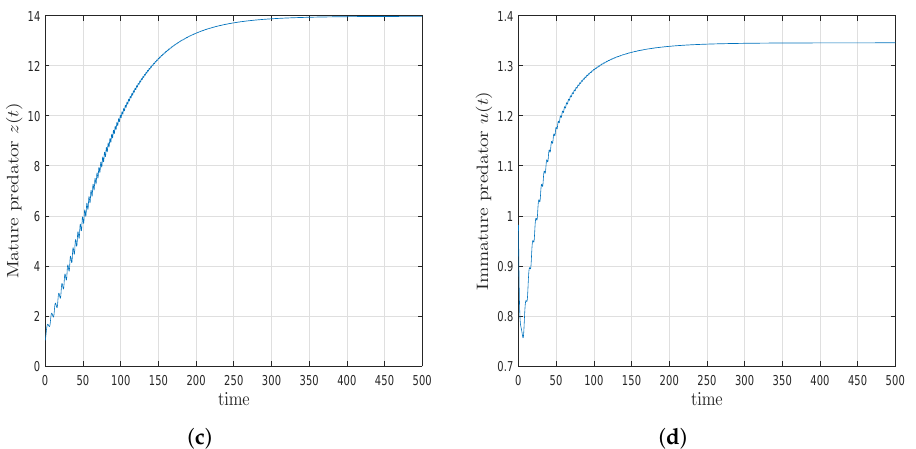
Figure 3. State variables x ( t ), y ( t ) z ( t ), and u ( t ) plots of food web mathematical System (13) with generalized Caputo fractional operator when ϕ = 1 and ρ = 1.1.